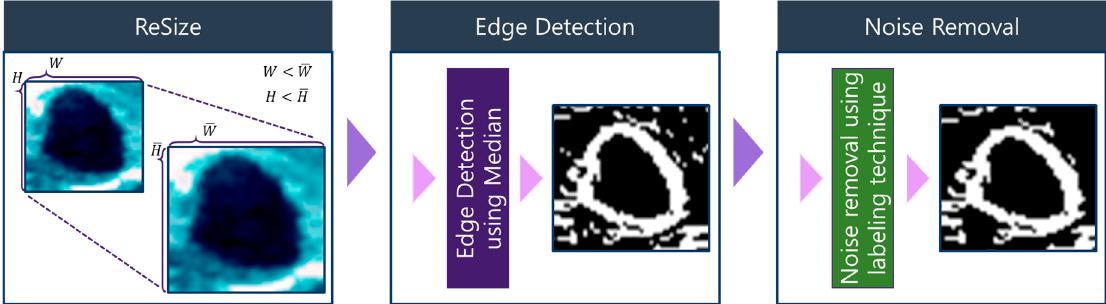
Figure 9. Image resize and edge detection.